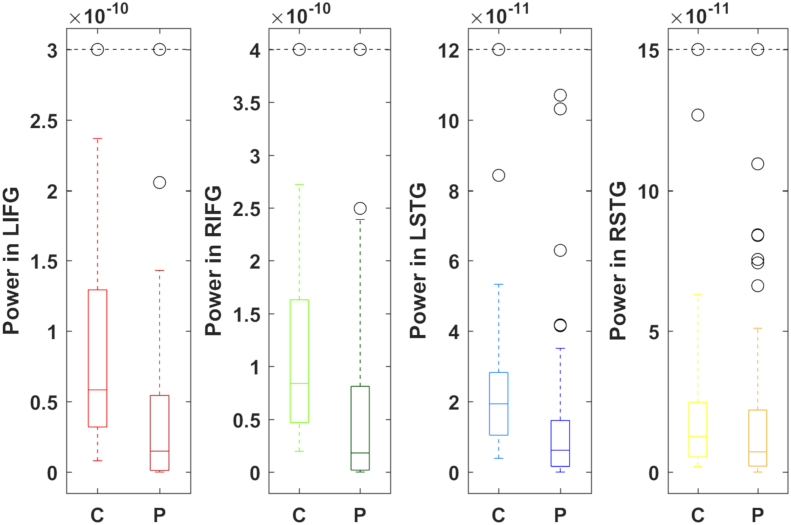
ALS patients show decreased power in both inferior frontal gyri and the left superior temporal gyrus. Boxes illustrate the interquartile range with whiskers illustrating the maximum and minimum power (A-m) within twice the interquartile range for ALS patients (P) and controls (C), determined by dipole fitting. Outliers are illustrated in black. Dashed line caps up to two outliers beyond this value. L – Left, R – Right, IFG – Inferior frontal gyrus, STG – Superior Temporal Gyrus.